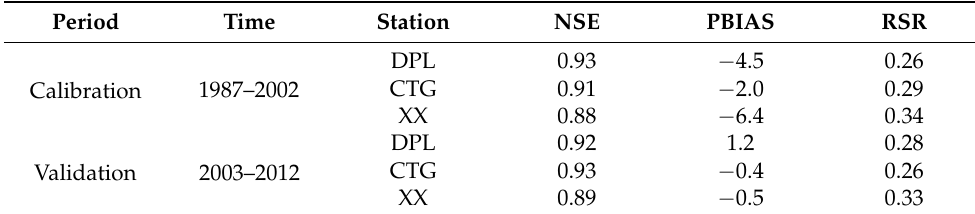
Table 2. Evaluation indicators for SWAT model calibration.